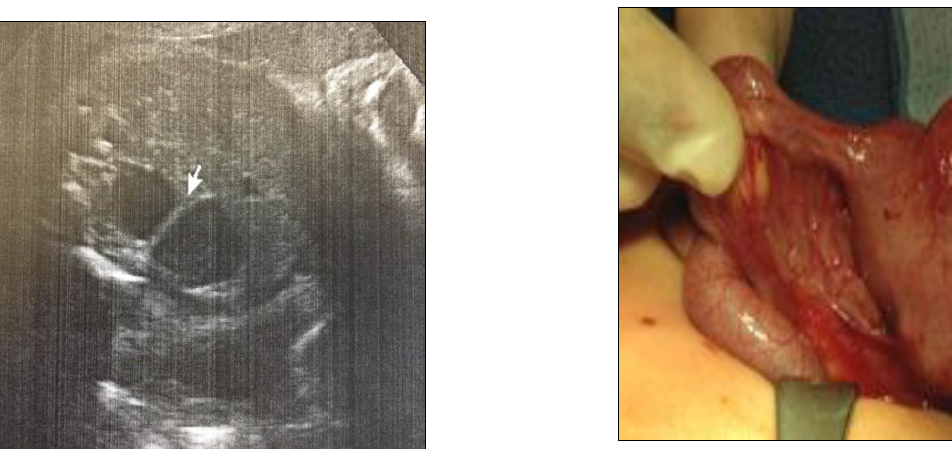
Figure 4: Operative findings of jejunal duplication